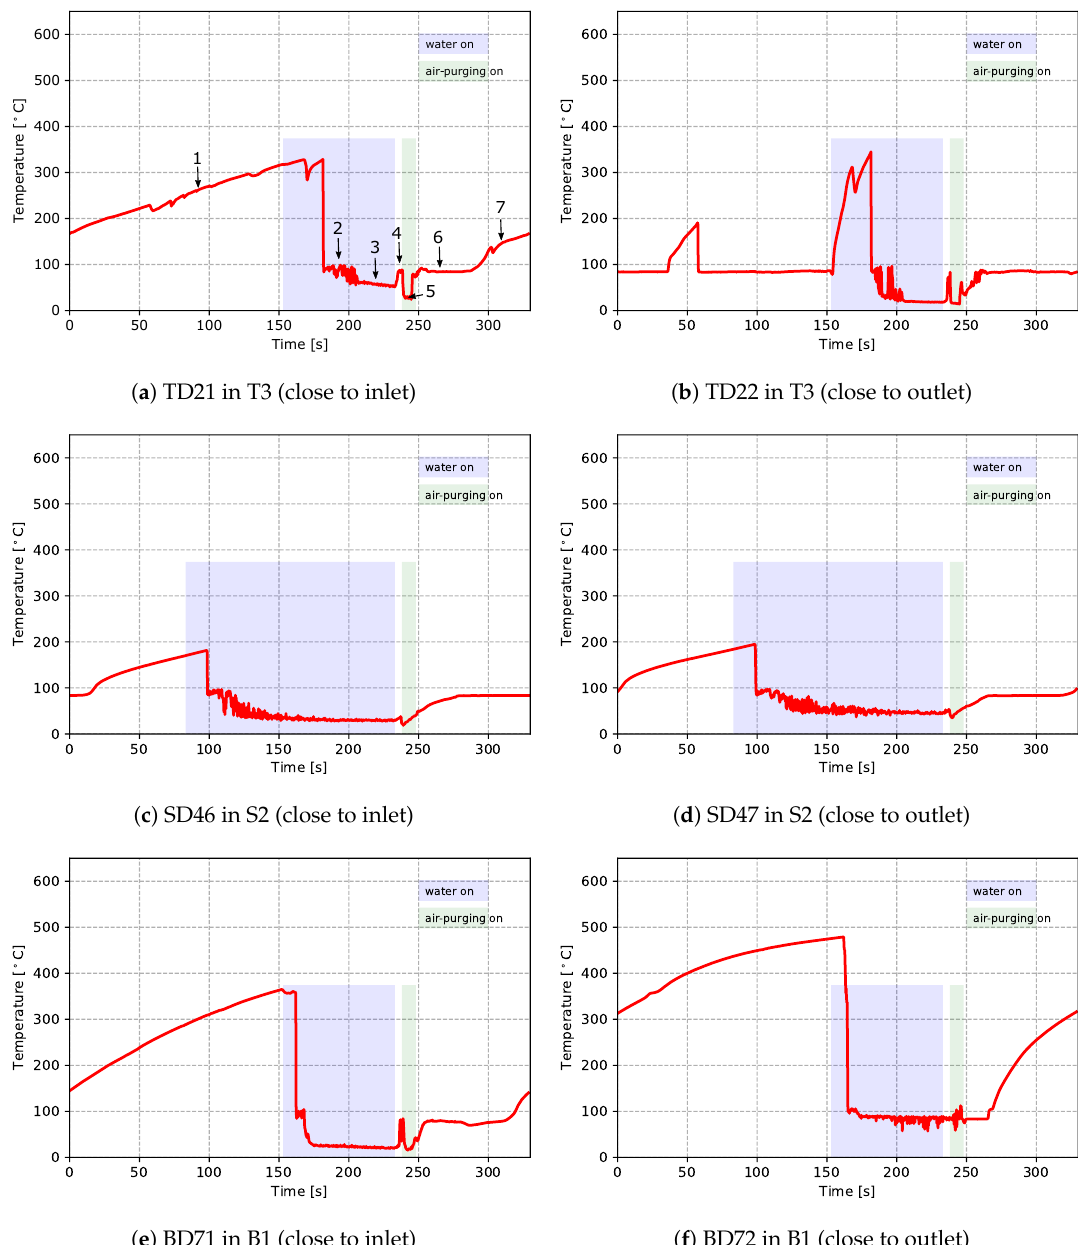
Figure 12. Temperatures measured within cooling channels—data from cycle 12 for the production process